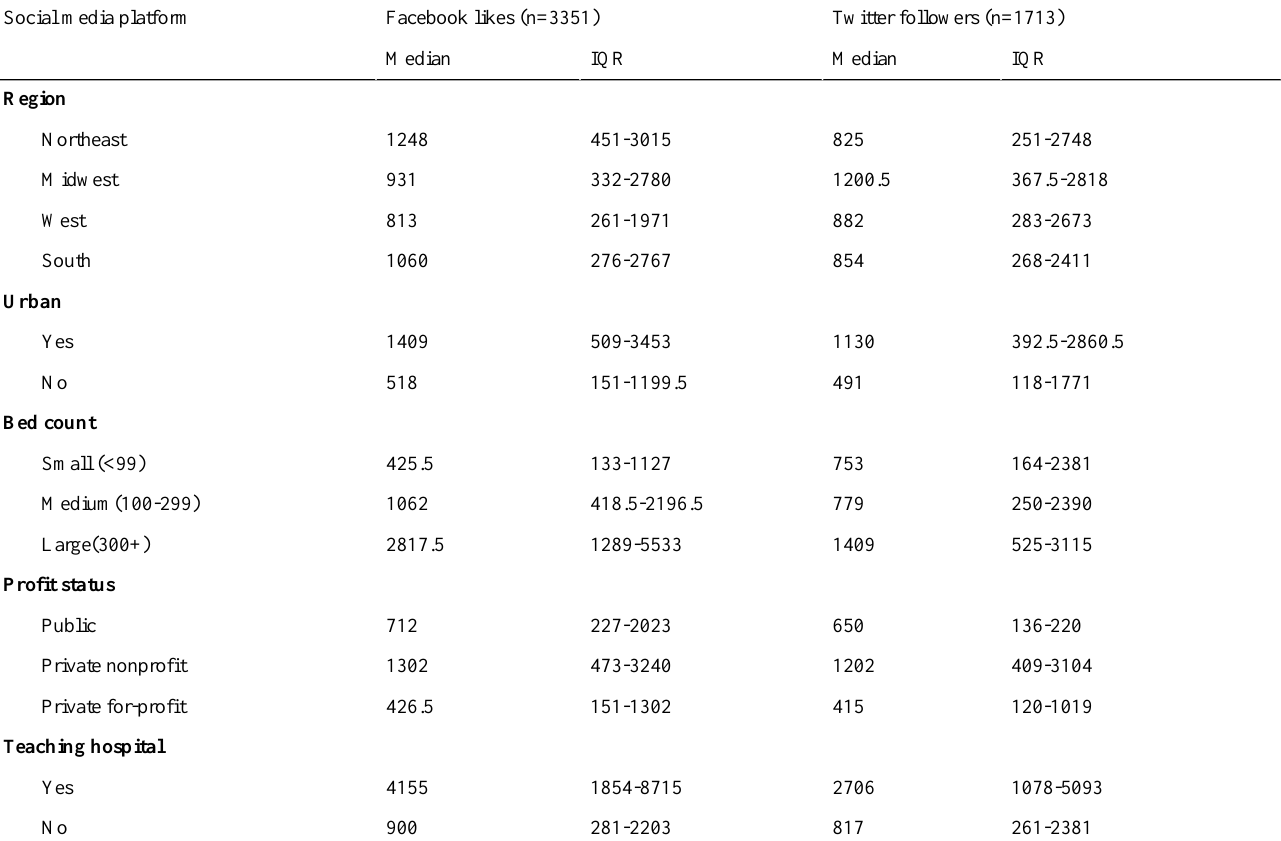
Table 1. Magnitude of social media utilization relative to hospital characteristics: Facebook and Twitter.